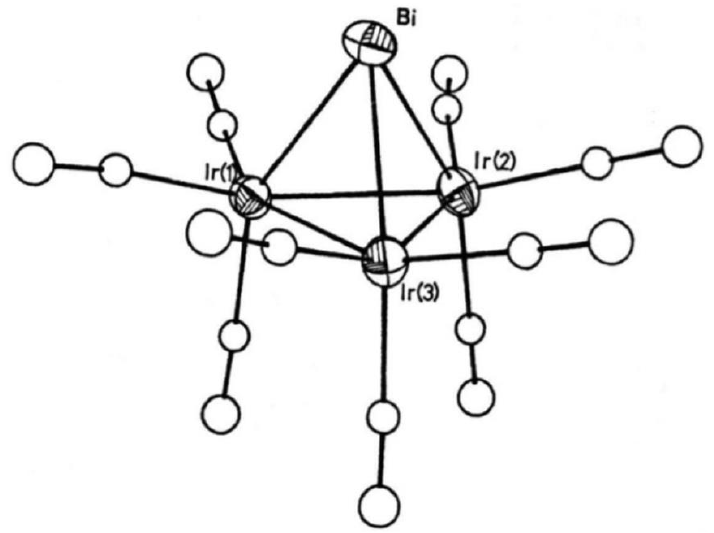
Figure 10. Schematic view of the X-ray structure of complex 15 [42].